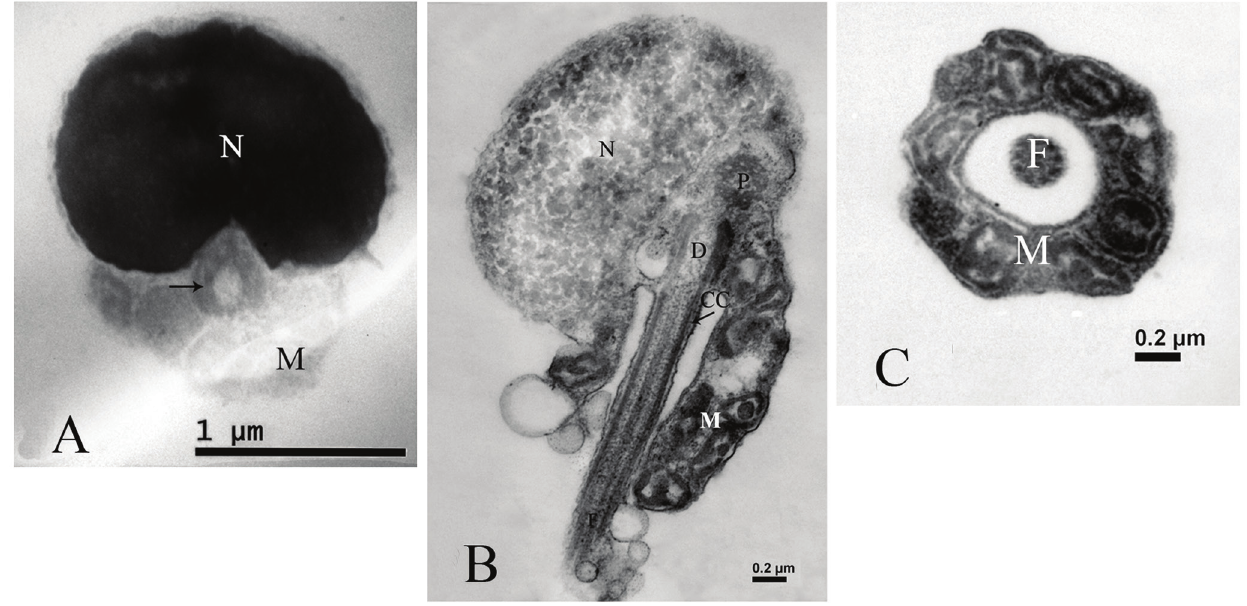
Fig. 2. Transmission electron microscopy photographs of fresh sperm samples: (A) Spermatozoa longitudinal section showing the transitional region of the flagellum and the classic nine doublets of microtubules (9+0), arrow. (B) Longitudinal section of the head and midpiece of a spermatid. (C) Transversal section of the midpiece showing the axoneme surrounded by mito- chondria. N: Nucleus; P: Proximal centriole; D: Distal centriole; CC: Citoplasmic Channel; M: Mitochondria; F: